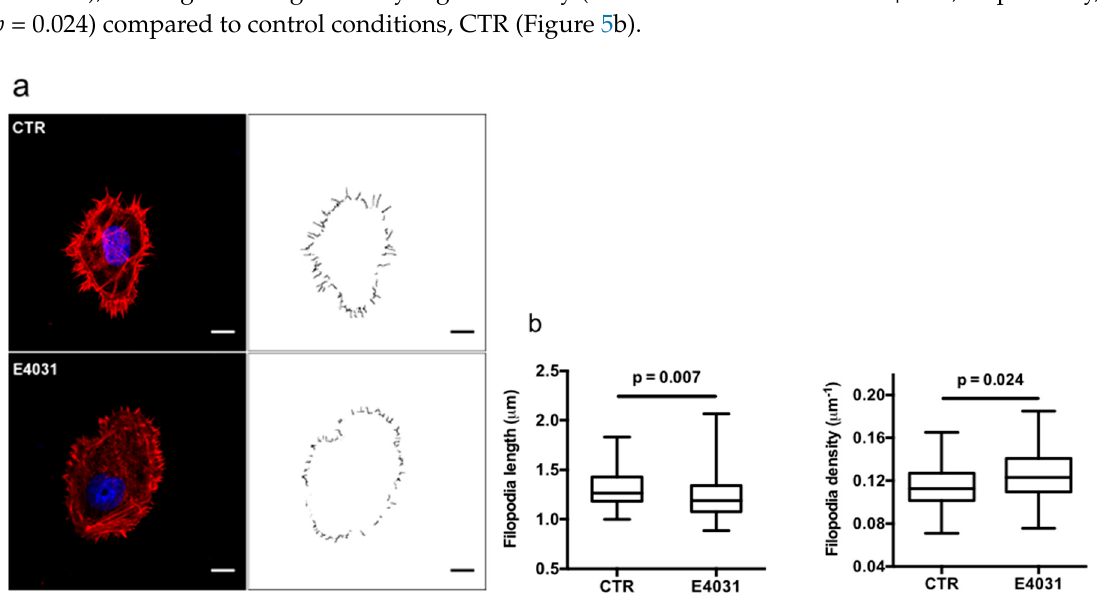
Figure 5. Actin filopodia formation in PANC-1 cells cultured onto DM plus Hypo-PSC-CM. ( a ) Representative confocal images of fixed PANC-1 cells in the absence (CTR) and presence of 40 µ M E4031 (E4031), after Hypo-PSC-CM stimulation. Actin and nuclei staining by rhodamine-conjugated phalloidin (red) and DAPI (blue). The right panels show the detected and segmented filopodia from the actin signal (see Materials and Methods section for details). Scale bars: 10 µ m. ( b ) Distribution of filopodia length averaged for each cell in CTR and E4031 conditions (left panel). Distribution of filopodia linear density calculated as the number of detected filopodia normalized for the cell perimeter in CTR and E4031 conditions (right panel). Boxes include central 50% of data points, the horizontal lines denote minimum value, median, and maximum value. At least a total of 40 cells per condition from three independent experiments were analyzed. All p -values were determined by a Mann–Whitney test (significant level set to p < 0.05), or for data deviating from normality by a Kolmogorov–Smirnov test.